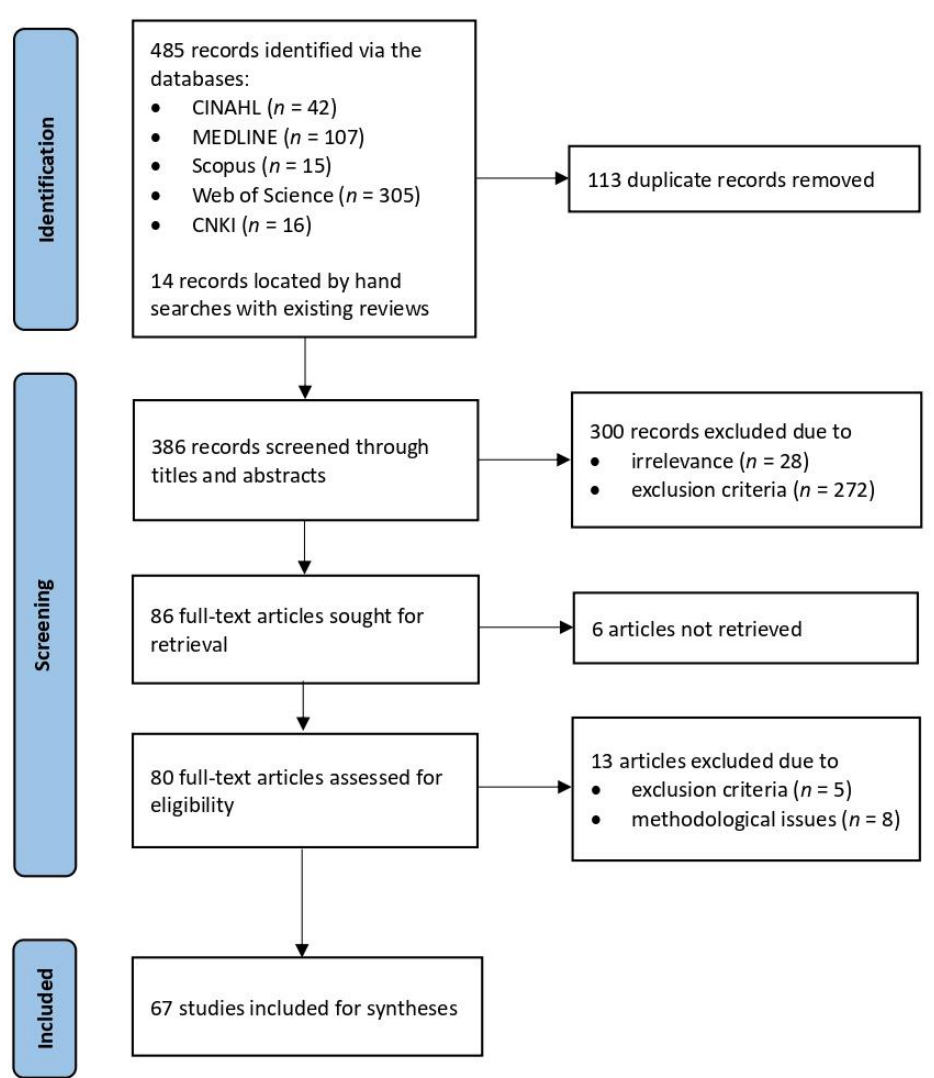
Figure 3. PRISMA flow chart of the study selection process.